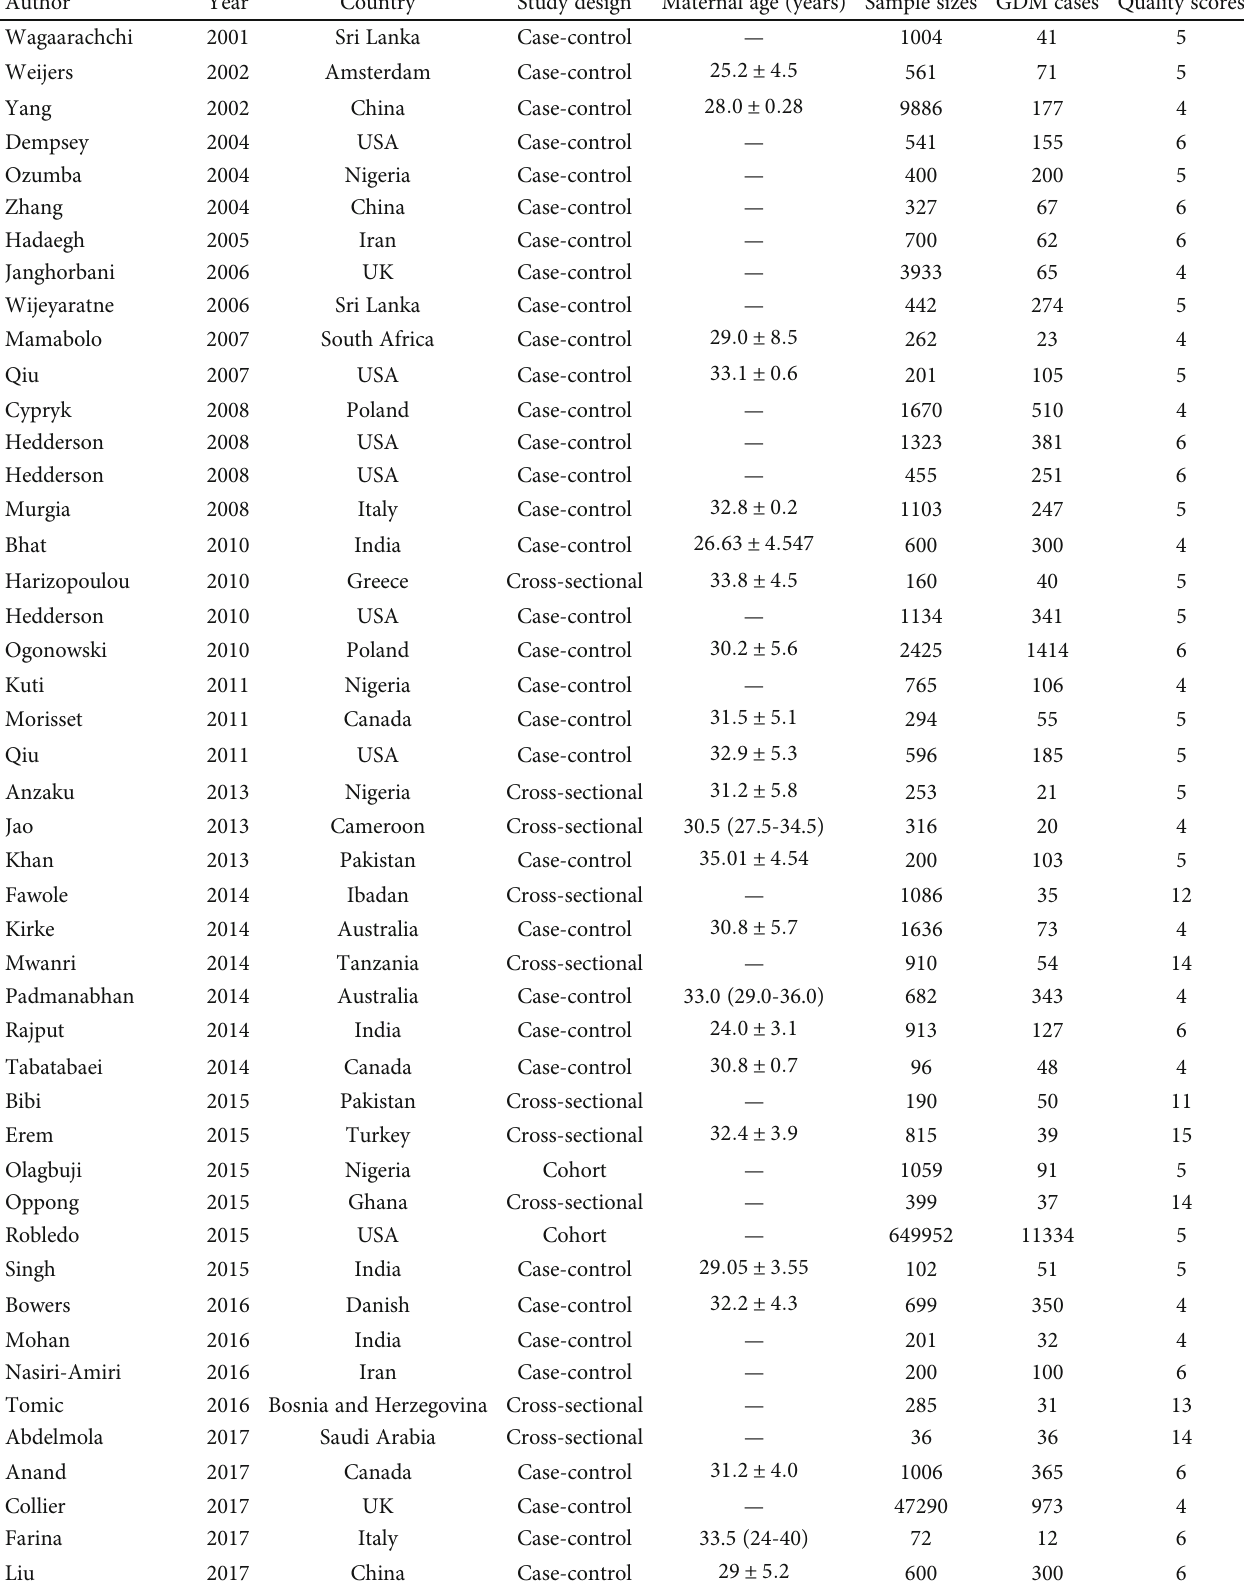
Table 1: Baseline characteristics of the included